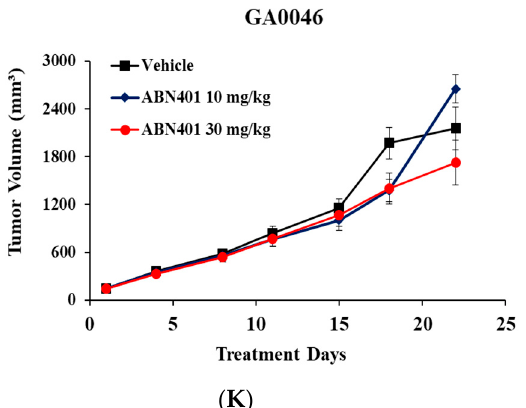
Figure 3. In vivo therapeutic efficacy of ABN401 in MET -addicted cancer cell xenograft and c-MET aberrant PDX models. ABN401 suppresses tumor growth in MET -addicted ( A ) SNU5, ( B ) EBC-1, and ( C ) SNU638 cell line xenografts, high MET copy numbers or c-MET IHC3+ and MET exon 14 skipping mutation ( D ) GA3121, ( E ) LI0612, ( F ) LU2503, and ( G ) LU5381 PDX models, but not in moderate MET copy number ( H ) GA2278, ( I ) GA0075, ( J ) GA0152, and ( K ) GA0046 PDX models. ABN401 was